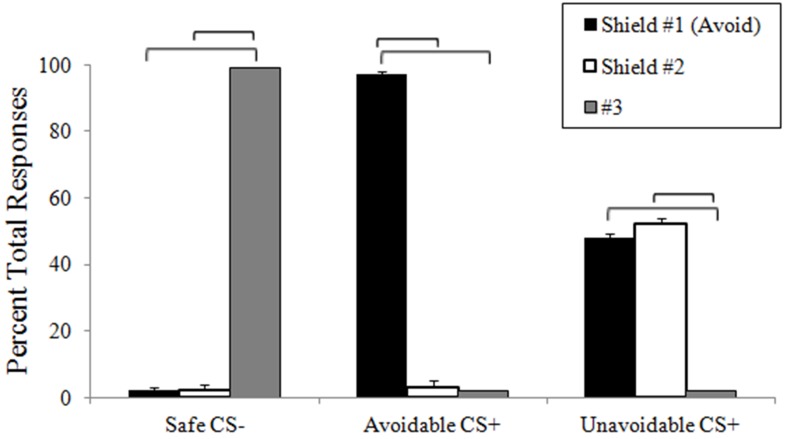
Response accuracy during avoidance task. The plot shows the distribution of choices among available responses (buttons 1, 2, and 3) to each CS during neuroimaging. Buttons 1 and 2 were described as “shields” that could help avoid alien attacks. The plot shows subjects consistently (and correctly) choice #3 to the CS− and correctly choice #1 to the Avoidable CS+, which prevented US delivery. In contrast, choices were distributed between #1 and #2 to the Unavoidable CS+ as subjects tried and failed to avoid the aversive US. (Brackets highlight significant differences, p < 0.05 corrected. Bars represent 95% confidence intervals).